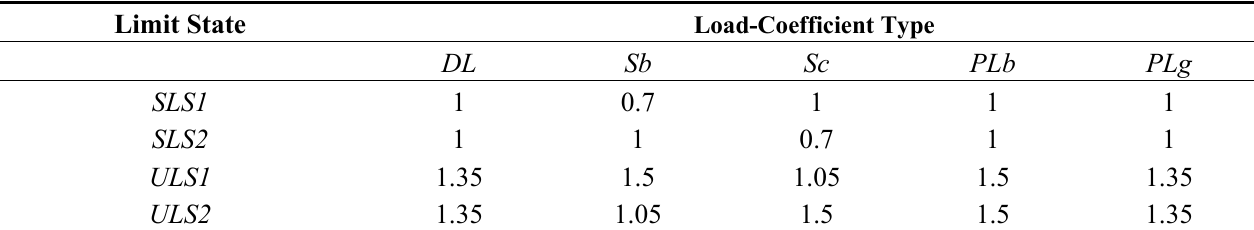
Table 1. Load combinations and applied coefficients according to the limit state and the type of load. SLS , serviceability limit state; ULS , ultimate limit